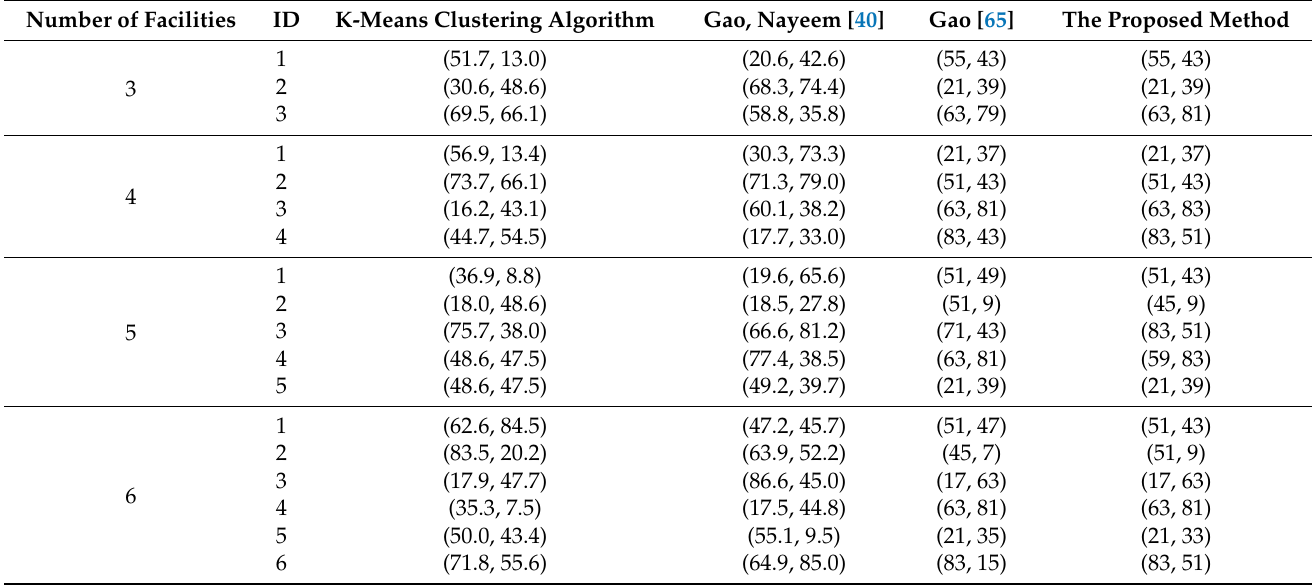
Table 6. Comparison of facility locations using different methods for Instance 24.